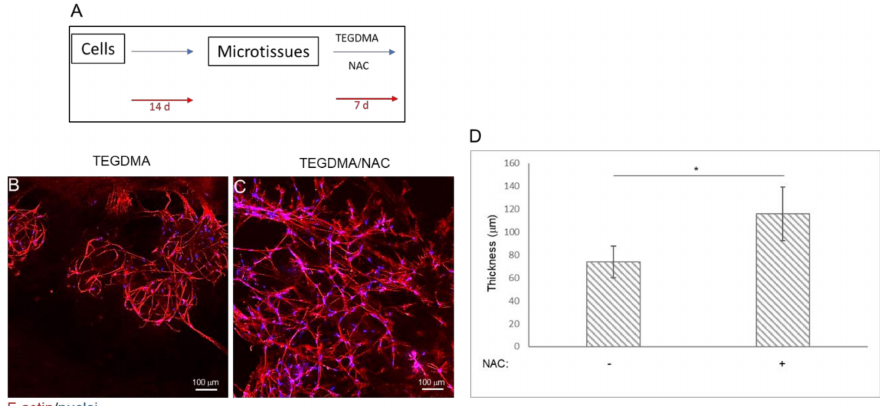
Figure 4. The spatial morphology of injured mature pulp microtissues rescued from structural deterioration by NAC treatment. ( A ) Schematic diagram of the experimental assay. ( B – C ) Confocal images of mature microtissues exposure to 2.5 mmol / L TEGDMA and ( B ) non-treated versus ( C ) treated with NAC. ( D ) Bar graph expresses the thickness of the non-treated vs. treated microtissues. * p ≤